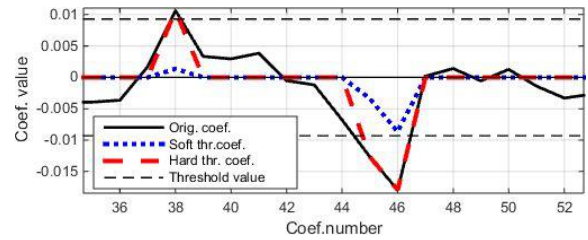
Figure 3. The principle of soft and hard thresholding.